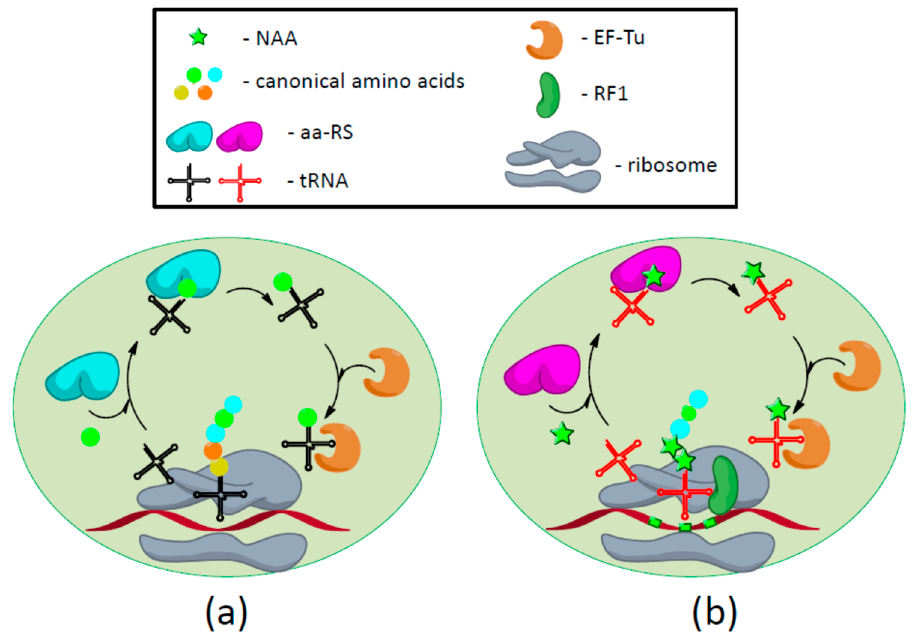
Figure 1. Schematic representation of expanded genetic code methodology. ( a ) Translation in E. coli cell: Endogenous aminoacyl-tRNA synthetases (aa-RS) (designed by cyan) charge tRNA (black colour) with cognate amino acids and aminoacyl-tRNA is transferred by elongation factor Tu (EF-Tu) to the ribosome. Proper interaction of mRNA codon and tRNA is required for the release of EF-Tu and peptide bond formation; ( b ) the methodology of genetic code expansion: NAA incorporation in response to amber stop codon is provided by supplying the organism with orthogonal aa-RS (violet colour) and suppressor tRNA (red colour). Suppressor tRNA is in competition with class I release factor (RF1).